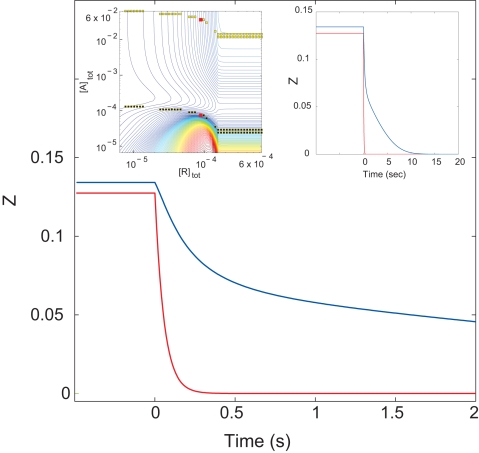
GAP-promoted deactivation of Gq after removal of receptor.Left inset: Segment of Figure 6 (cytosolic nucleotide concentrations) showing the results of a search of R-A space for pairs of high and low GAP concentrations where a 500-fold increase in GAP concentration caused less than 15% decrease of Z at steady-state but caused at least a 2-fold increase in the rate of deactivation when the concentration of receptor was instantaneously set to zero (see Materials and Methods). Dot spacing reflects the search grid. Pairs that met the criteria were found for all concentrations of receptor. Gq activation was first simulated at steady-state in the presence of 8.9×10−5 M receptor (red dots in left inset). At zero time, the concentration of receptor was set to zero. The upper and lower curves represent 7.4×10−5 M and 3.7×10−2 M GAP. Right inset shows the same deactivation reaction over a longer time.